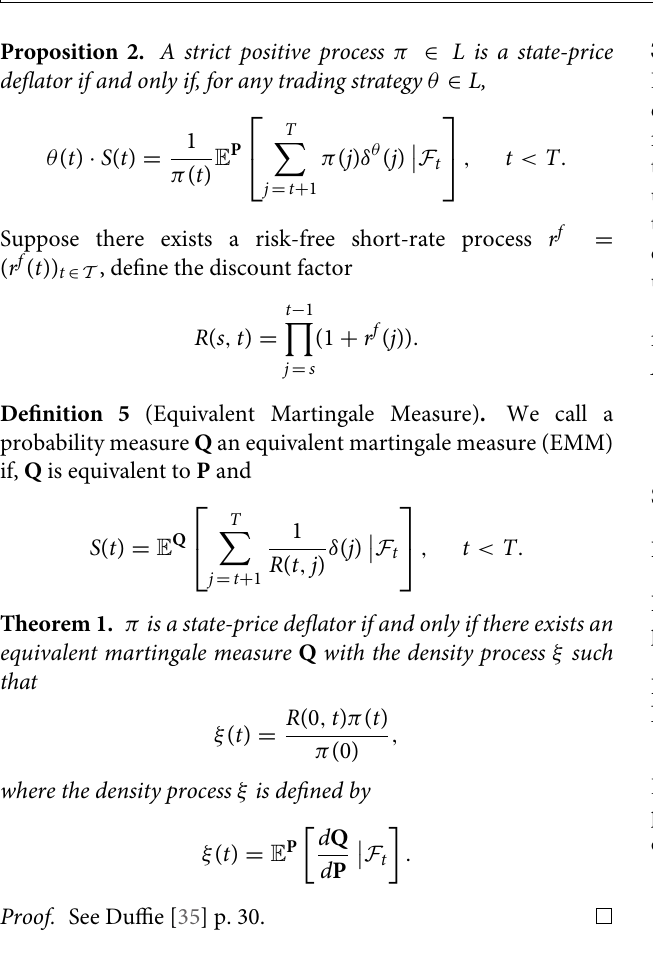
FIGURE 1 | Example: Arbitrage opportunity in case of information